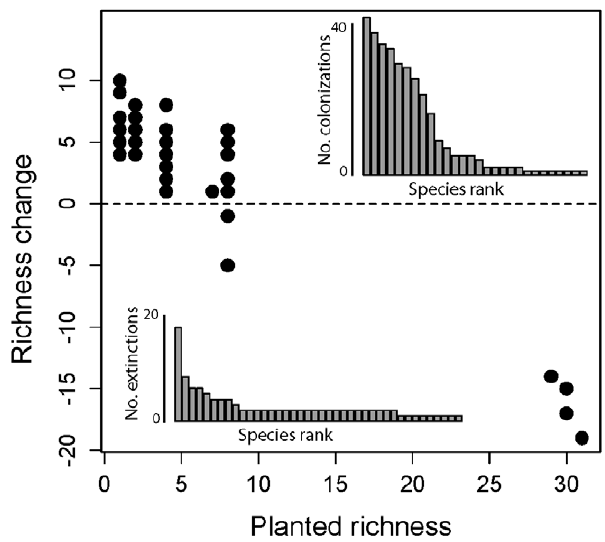
Figure 1. The relationship between change in the number of species in a plot and the number of species planted. Inset histograms show the number of extinction and colonization events for individual